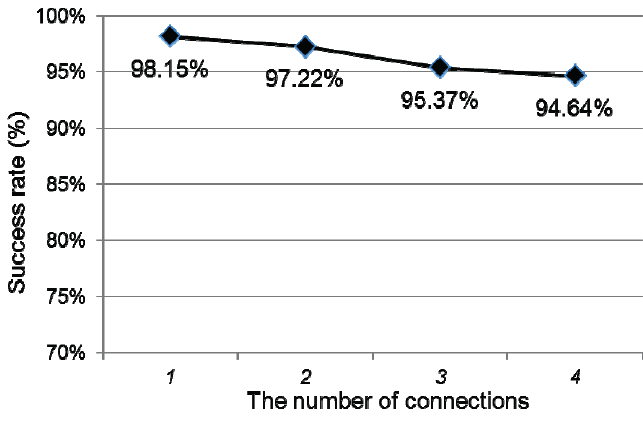
Figure 16. Stability of emergency message